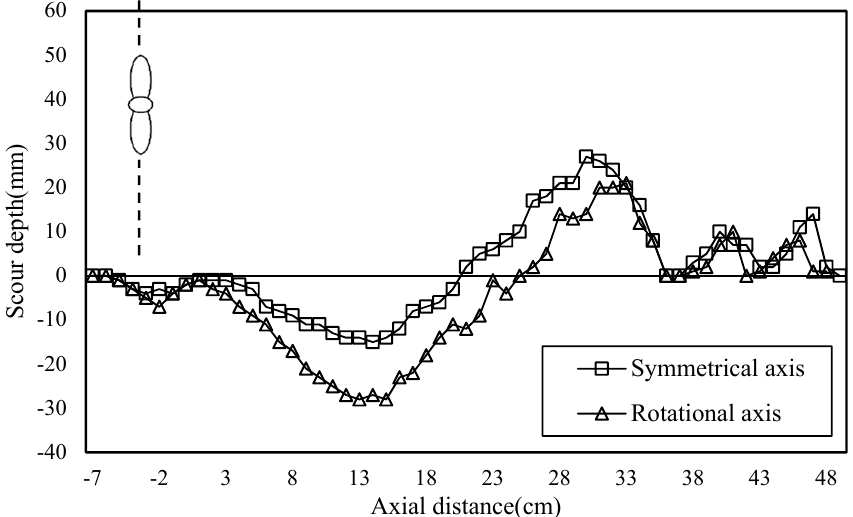
Figure 11. Scour on rotational axis and symmetrical planes for twin ‐ propeller.